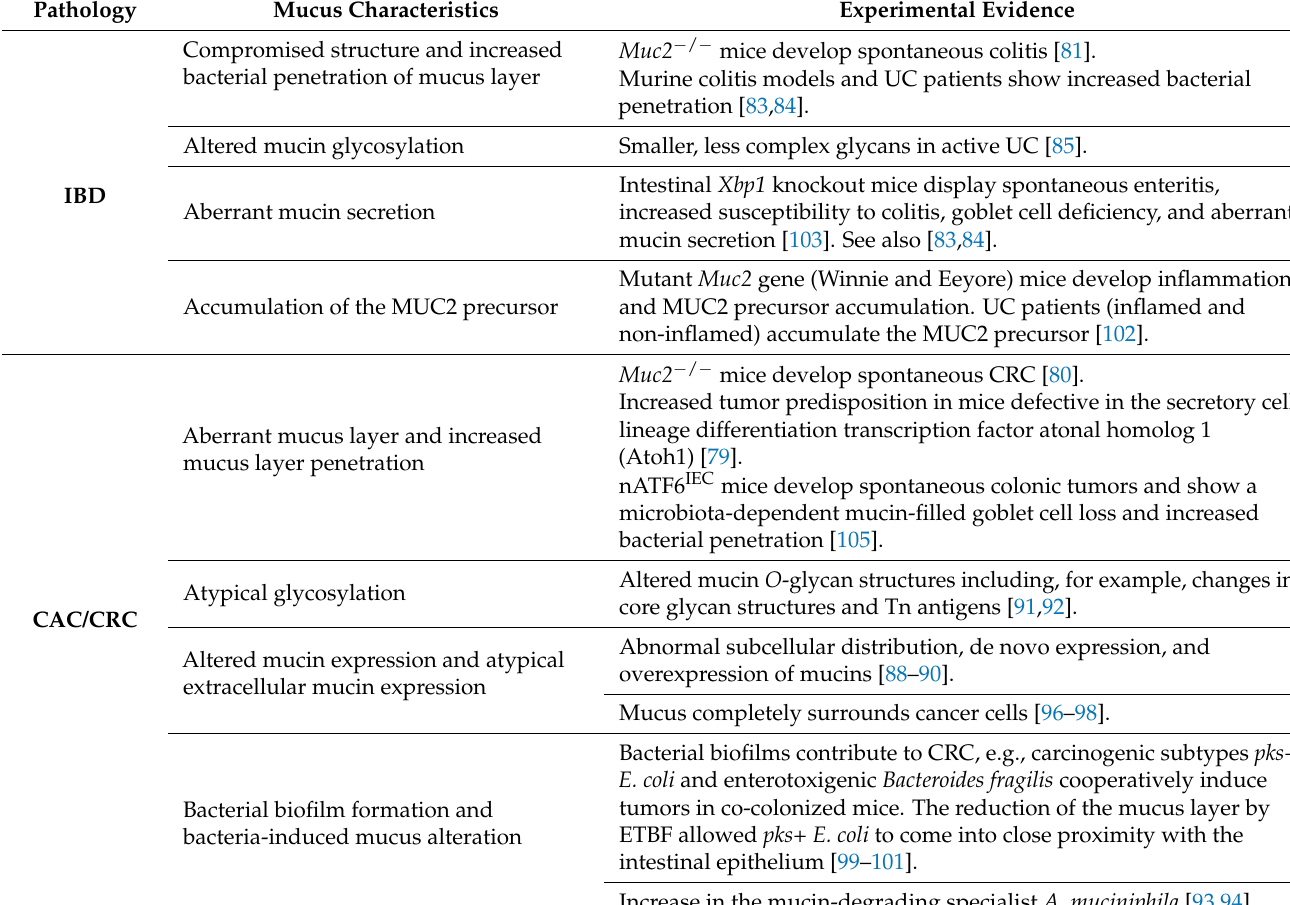
Table 1. Summary of mucus characteristics and microbe–mucus interactions observed in IBD and